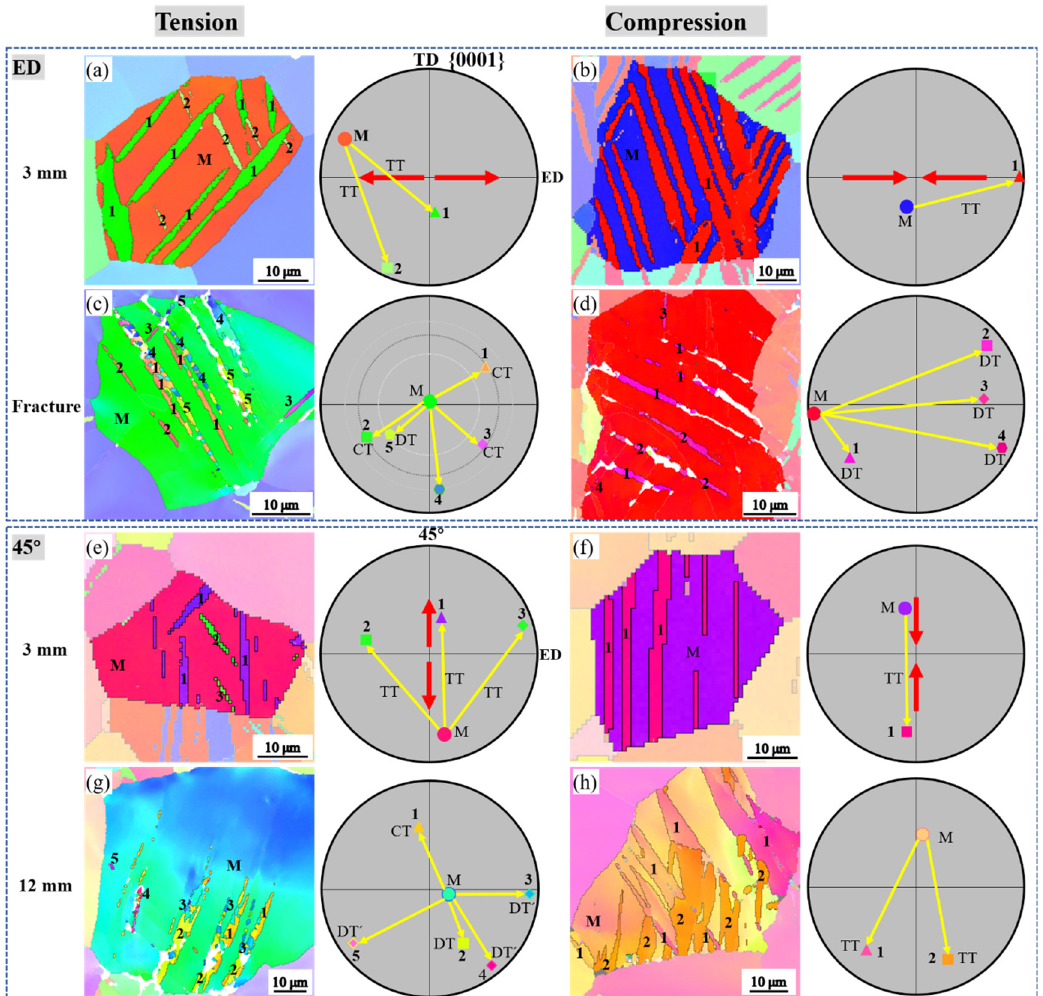
Figure 8. Illustration of orientation shift process caused by twinning in the bent ED and 45° bar: ( a , b ) tensile twinning in tension and compression at a bending displacement of 3 mm in ED bar; ( c , d ) contraction twinning and double twinning at fracture in ED bar; ( e , f ) tensile twinning at a bending displacement of 3 mm in 45° bar; ( g , h ) contraction twinning and double twinning at a bending displacement of 12 mm; all twinning types and variants identified were numbered (the selected grains have been marked with black rectangles in Figures 4–7).